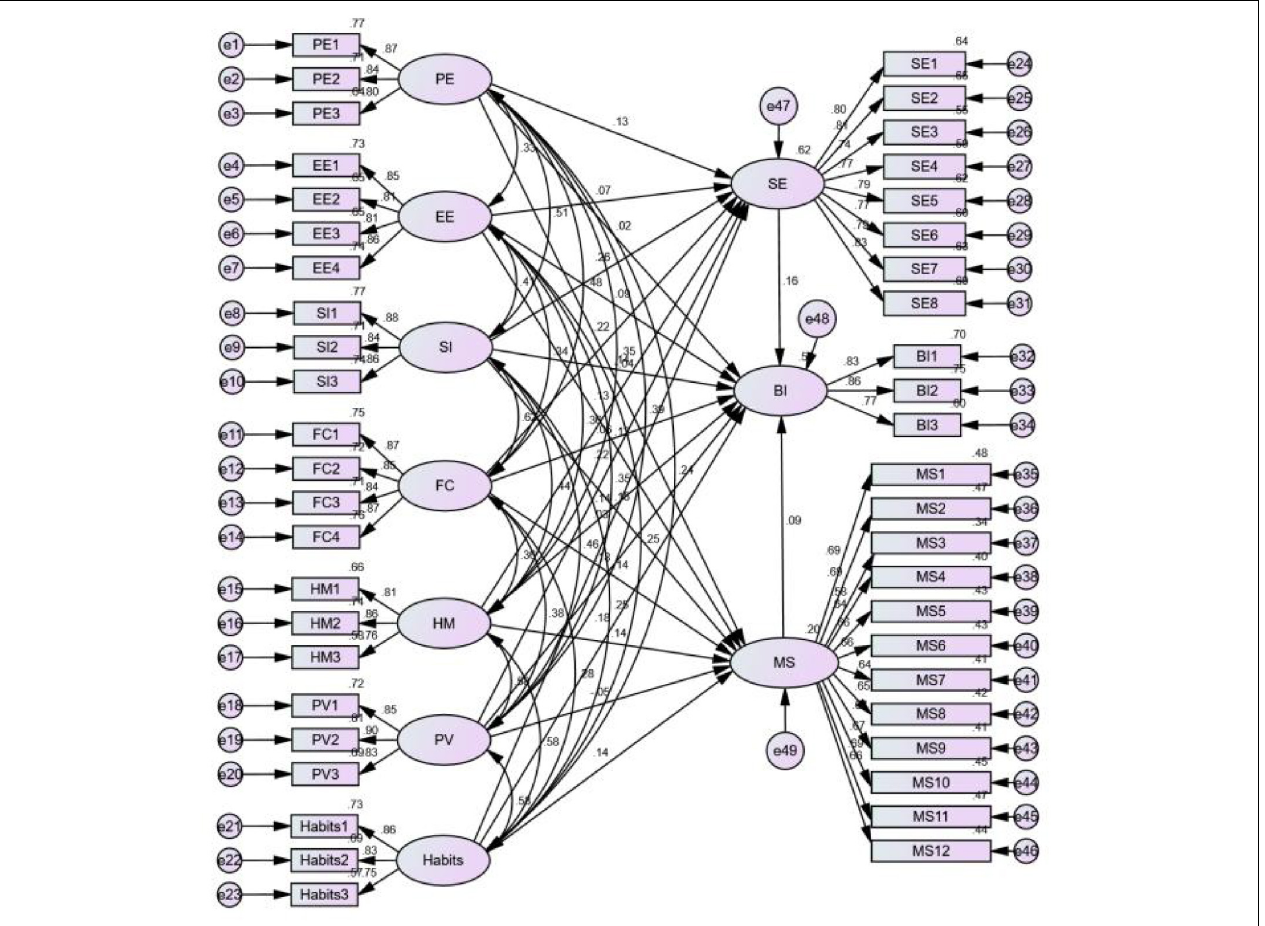
FIGURE 3 | SEM of UTAUT2-based